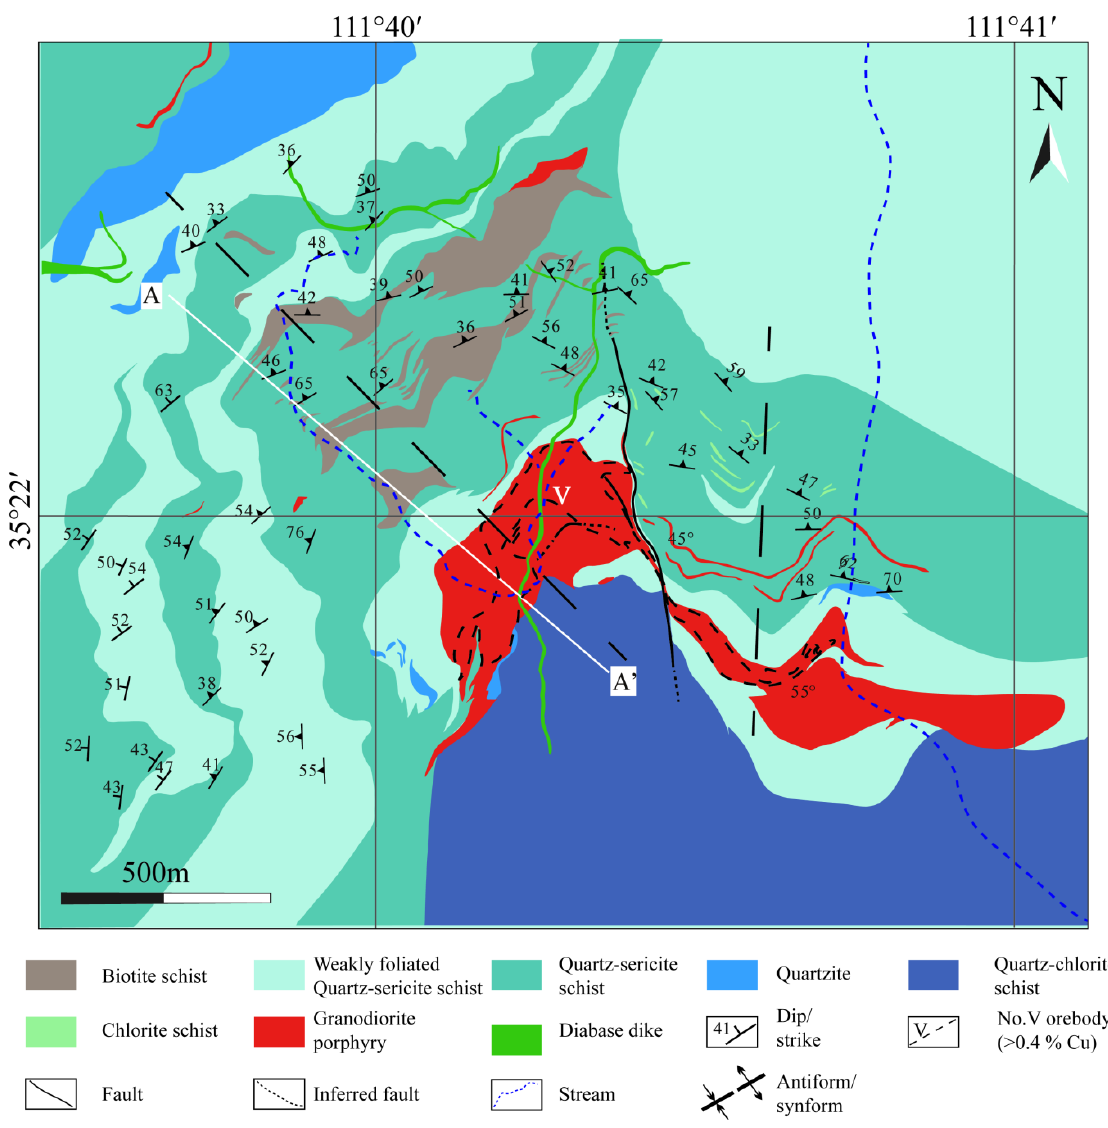
Figure 2. Simplified geologic map of the Tongkuangyu Cu deposit (modified after 214 Geological Group in Zhongtiaoshan in Shanxi Province, unpub. report, 1956; Meng et al., 2020 [8]). Cu mineralization is restricted to Luotuofeng Formation and granodiorite porphyry intrusions (Figure 3 ), and occurs in five main orebodies (Nos. 1‒5). Among them, No.4 and 5 orebody are the largest in scale, with reserves accounting for more than 85% of the whole deposit, and are hosted by granodiorite porphyry. No.1, 2, and 3 ore bodies are small in scale and mainly occur in biotite schist. No.5 ore body starts from Shuiyaogou in